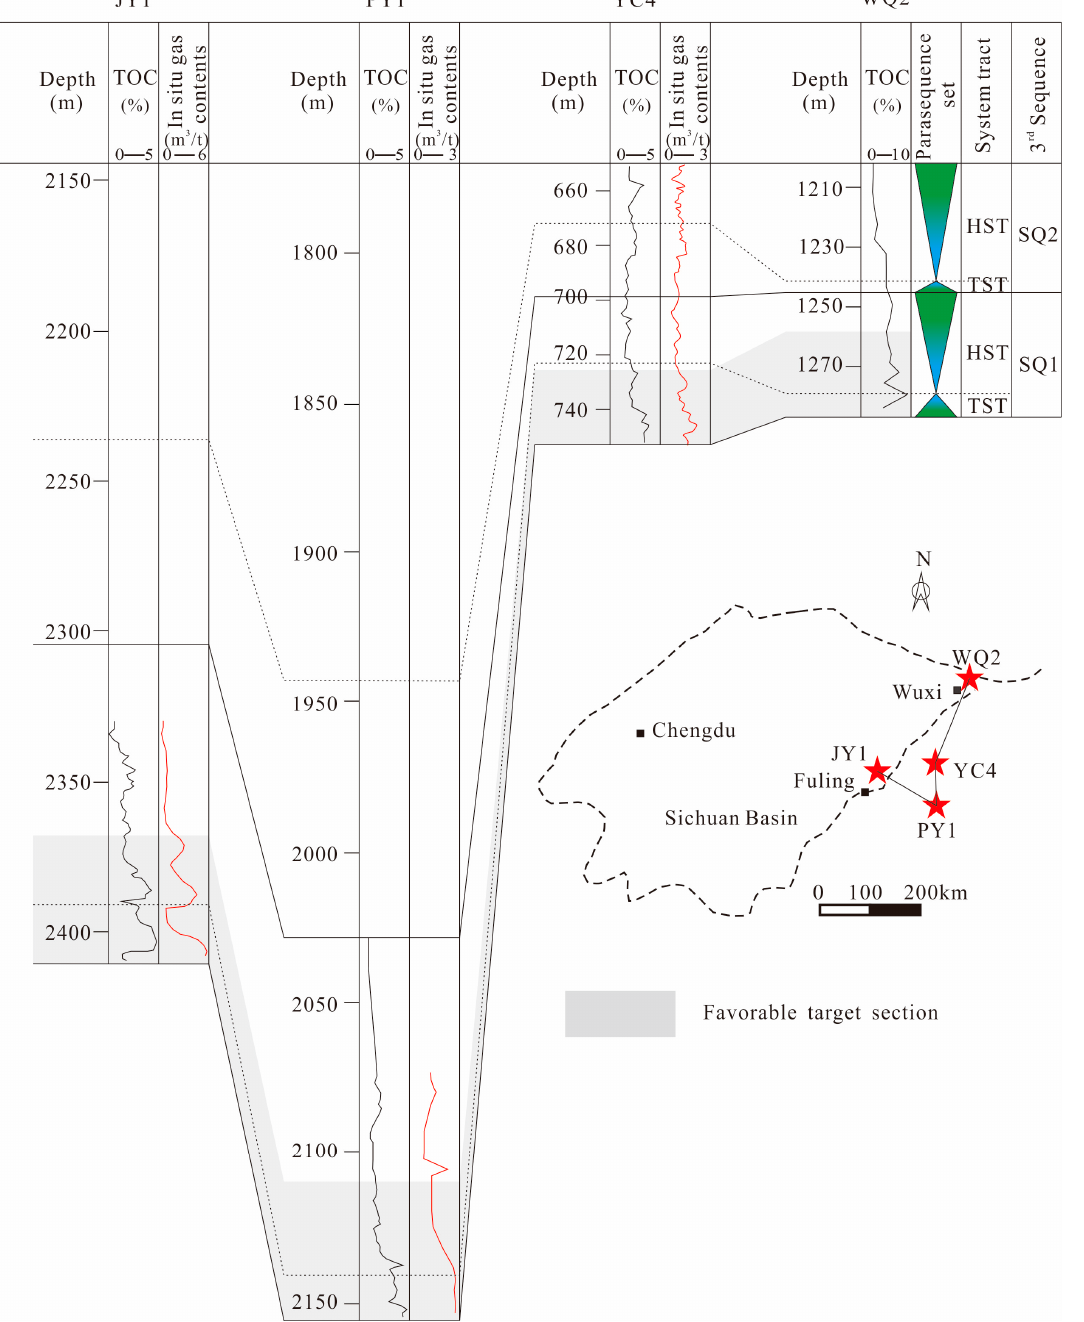
Figure 12. Sequence framework of the Longmaxi Formation across the southeastern and northeastern Sichuan Basin. The data for Well-JY1 and Well-PY1 are referenced from Chen et al. [7], and Well-YC4 is from Xiong et al. [8].